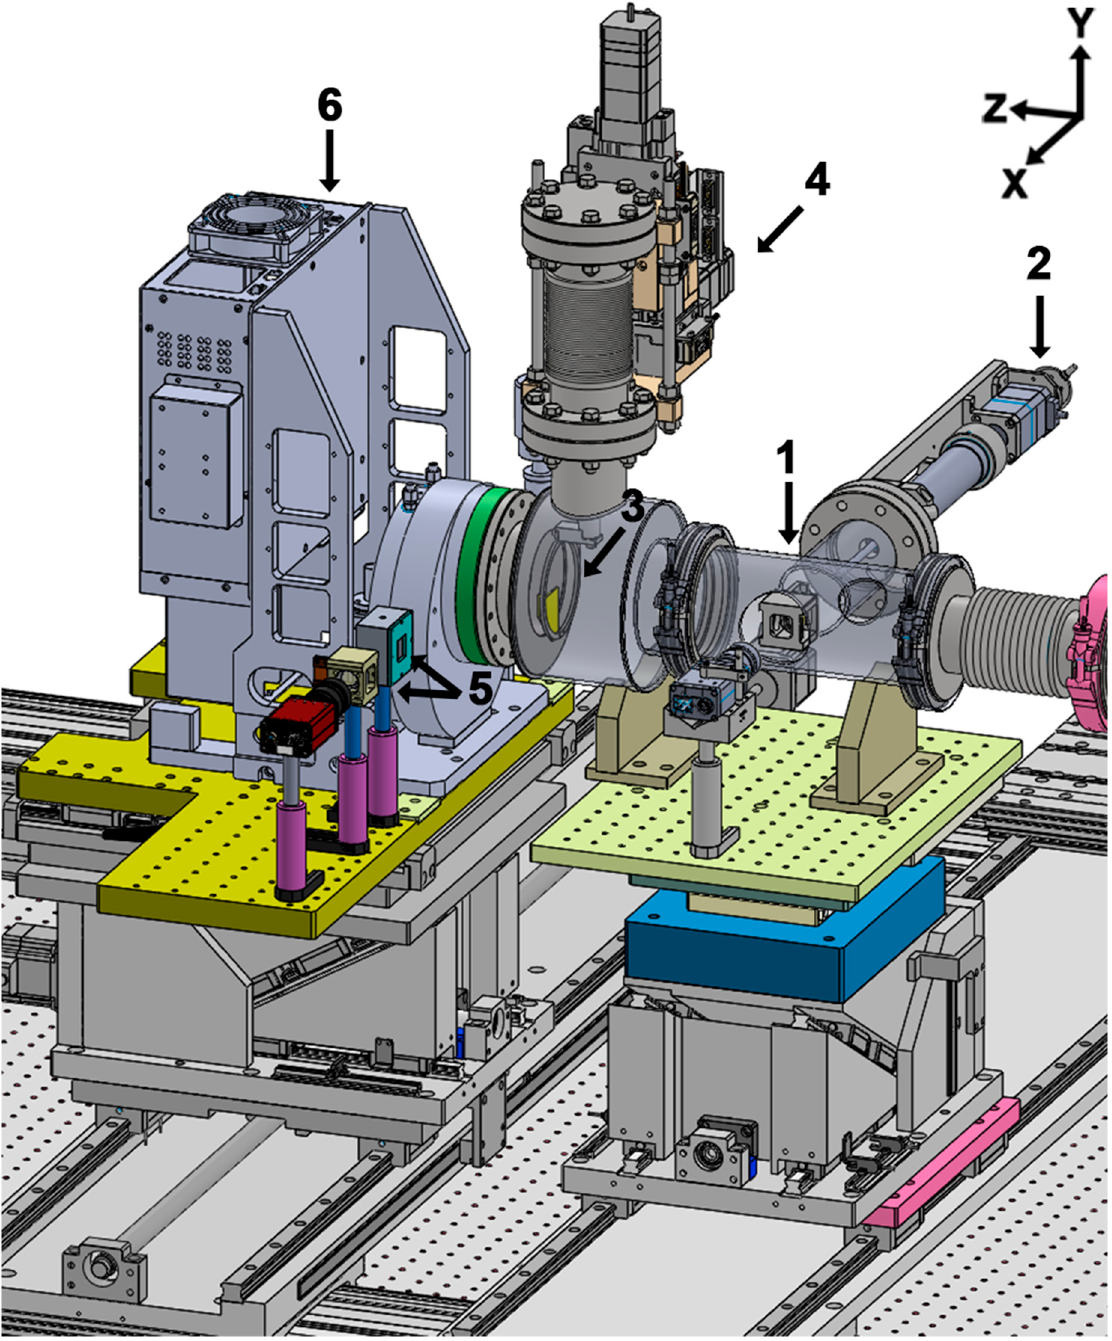
Figure 4. A schematic view of the detector part. (1) Beam position monitor, photodiode, and YAG crystal. (2) Linear manipulator for beam position monitor. (3) Ta metal beam stopper with 2 mm thickness. (4) XY manipulator for the beam stopper. (5) Beam position monitor, photodiode, and YAG crystal. (6) MPCCD detector.